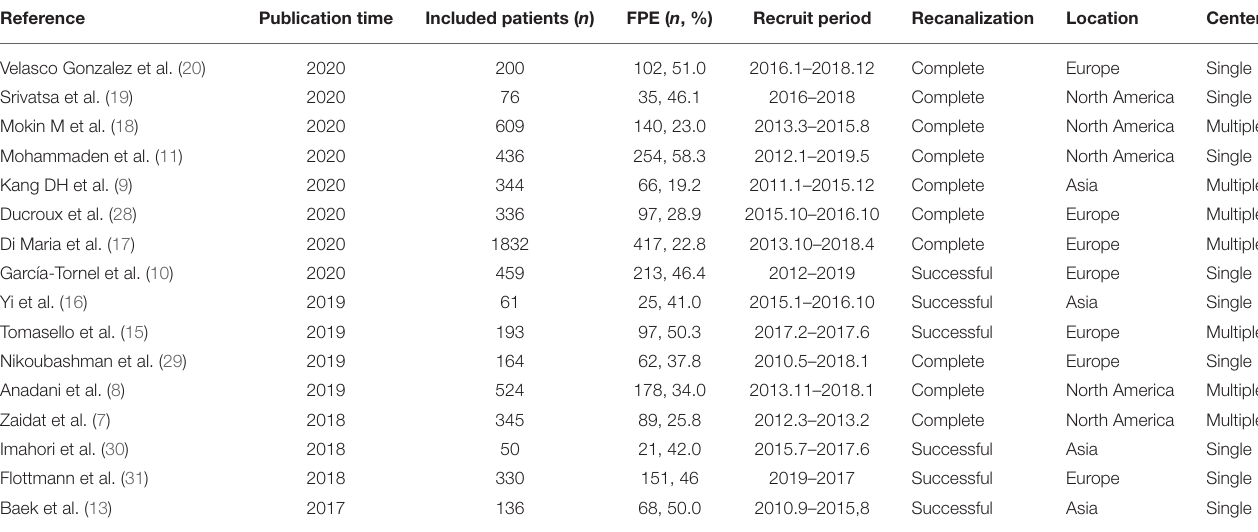
TABLE 1 | Main characteristics of included